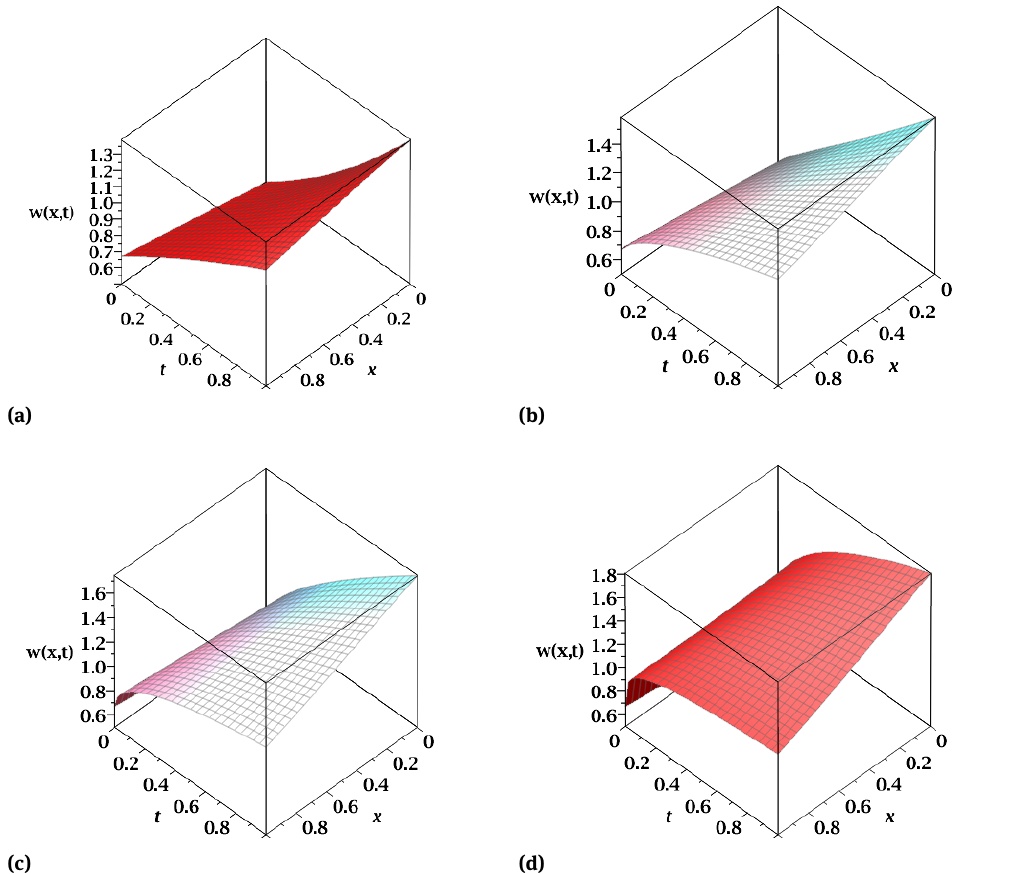
Fig. 3: (a) Numerical simulation of w ( x , t ) at β = 1 when ρ = −1, for Ex. 5.2; (b) Numerical simulation of w ( x , t ) at β = 0.75 when ρ = −1, for Ex. 5.2; (c) Numerical simulation of w ( x , t ) at β = 0.5 when ρ = −1, for Ex. 5.2; (d) Numerical simulation of w ( x , t ) at β = 0.25 when ρ = −1, for Ex. 5.2